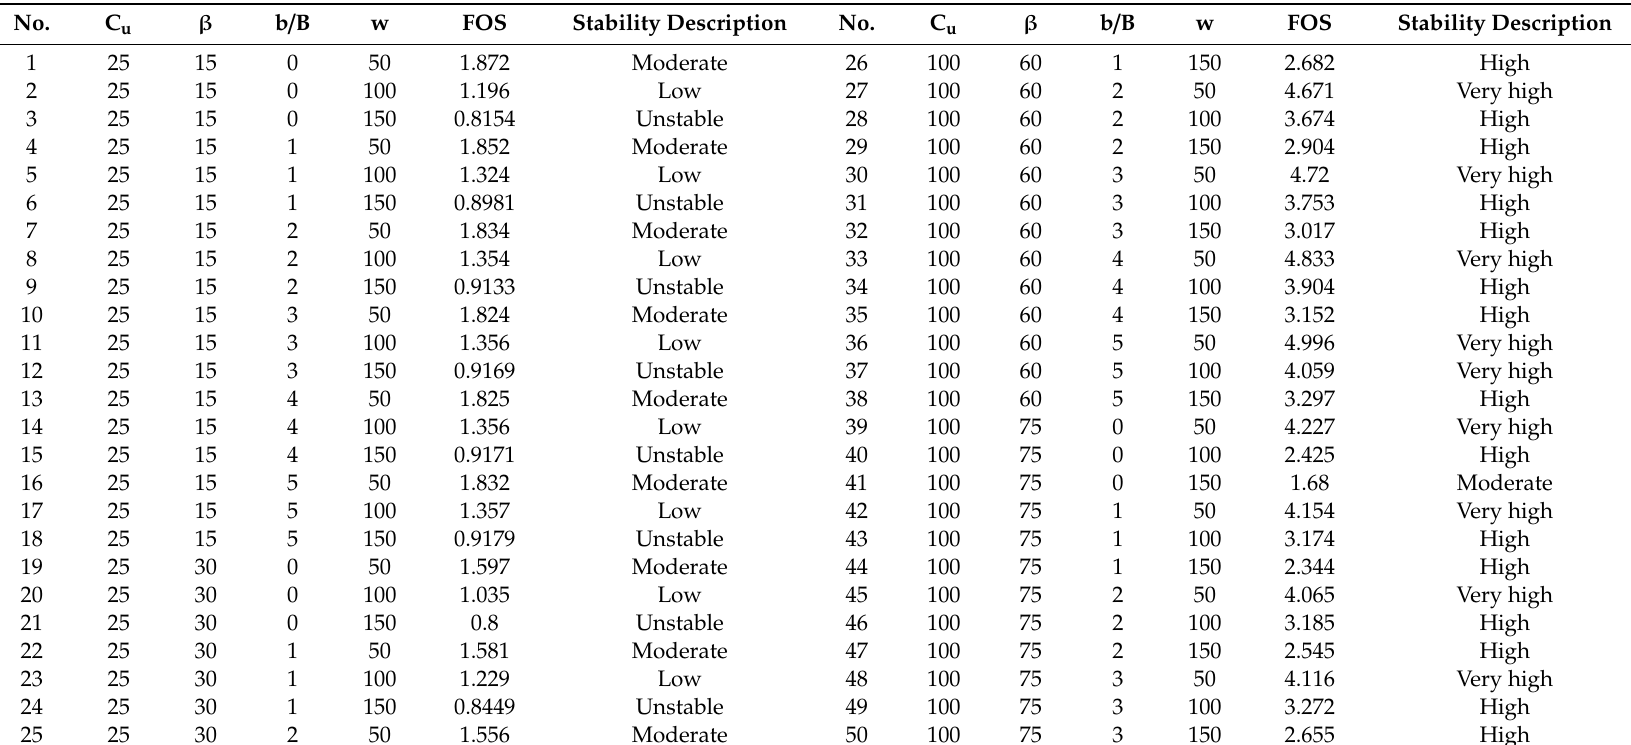
Table 1. Example of inputs and output dataset used for training and validating the applied